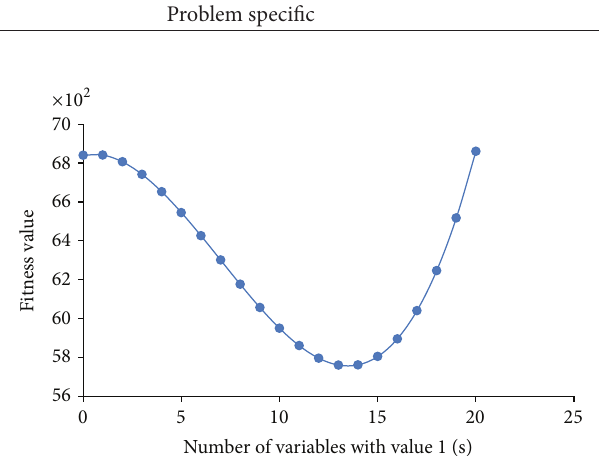
Figure 3: COUNTSAT function with 𝑛 being